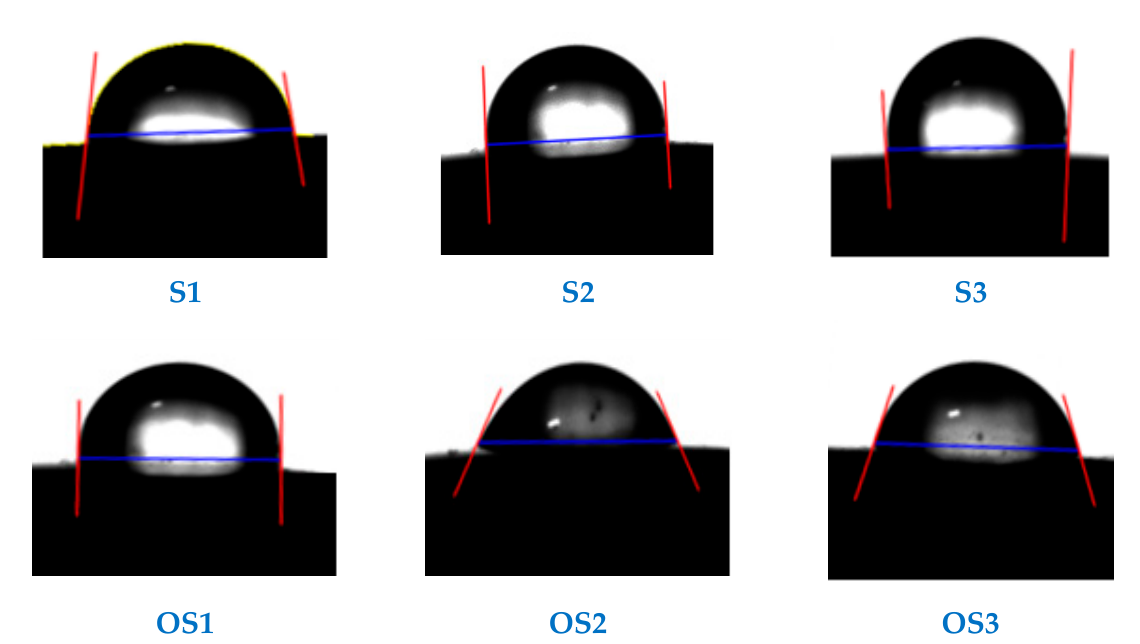
Figure 6. Contact angle measurements for a liquid drop 25 wt.% glucose solution poured on the surface of the stainless steel grades, before and after the heat treatment process.